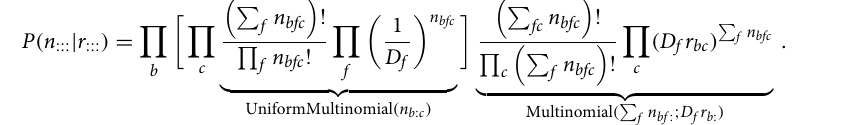
where colons indicate index ranges, e.g. n ::: = { n b 1 f 1 c 1 , n b 1 f 1 c 2 , n b 1 f 1 c 3 , n b 1 f 2 c 1 , . . . , n b D c are the numbers of birds, food types and compartments, respectively. If the rates are independent of the food